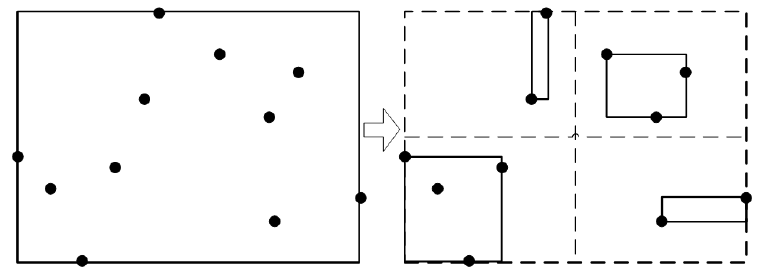
Figure 4. The schematic diagram of how to allocate the vortex particles into the tree structure.